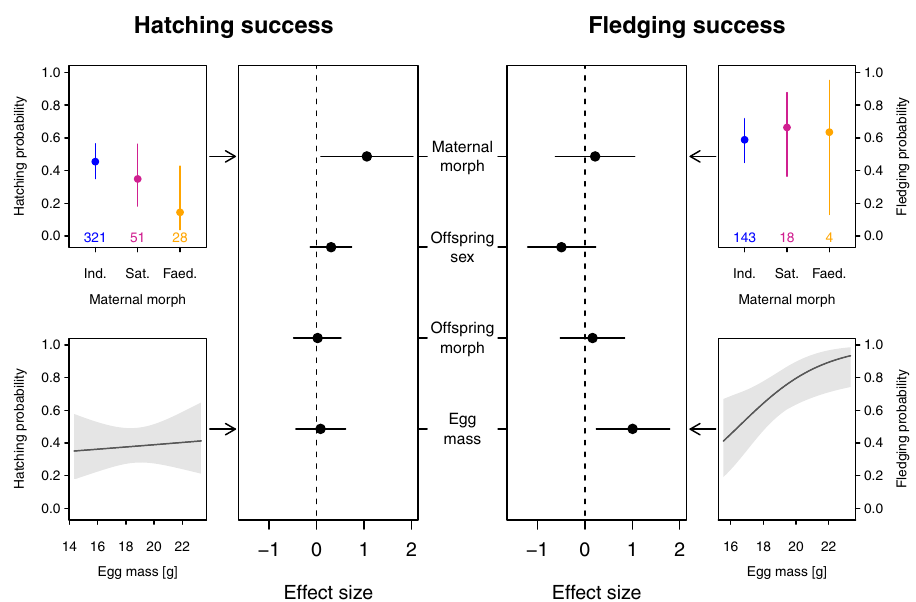
Fig. 2 Co-variates of hatching and fl edging success. Central panels: Effect sizes (means ± 95% CrI) of maternal morph (controlled for egg mass), offspring sex, offspring morph and egg mass on hatching and fl edging success. The models include mother ID and sampling year as random factors. Side panels: In fl uence of the maternal effects: maternal morph (top) and egg mass (bottom) on hatching and fl edging probabilities (means ± 95% CrI). For visualization, the estimates of maternal morph on hatching and fl edging probabilities were calculated for Independent male embryos using the overall mean egg mass (hatching: 18.61 g, fl edging: 18.68 g). Similarly, the estimates of egg mass on hatching and fl edging probabilities were visualized using Independent mothers and Independent female offspring. For hatching success, the probabilities of effect sizes being less than zero (P( β < 0)) were: 0.02 for maternal morph, 0.09 for offspring sex, 0.47 for offspring morph, and 0.38 for egg mass. For fl edging success, the probabilities of effect sizes being less than zero (P( β < 0)) were: 0.31 for maternal morph, 0.91 for offspring sex, 0.32 for offspring morph, and <0.01 for egg mass. Sample sizes were 400 eggs from 87 mothers for hatching success and 165 chicks from 62 mothers for fl edging success. Sample size details are provided in methods and model details and all other estimates on hatching and fl edging probabilities are provided in Supplementary Tables 4 and 5. Source data are provided as a Source Data fi